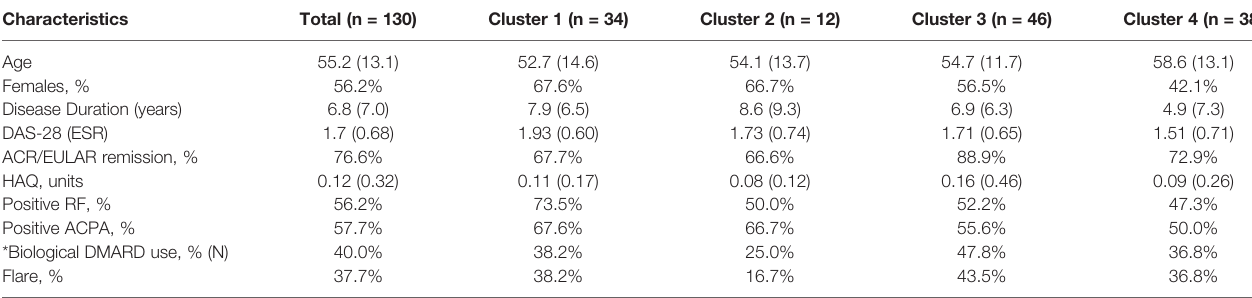
TABLE 1 | Baseline characteristics of the patients, split by proteomic cluster.